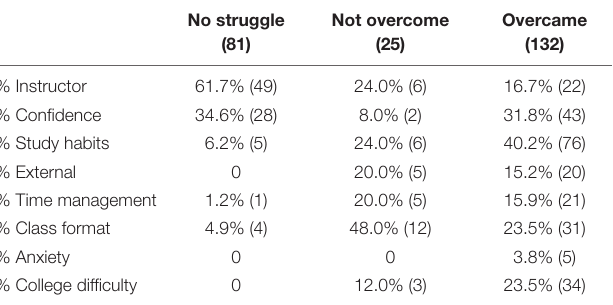
Parentheses indicate how many students were grouped into each